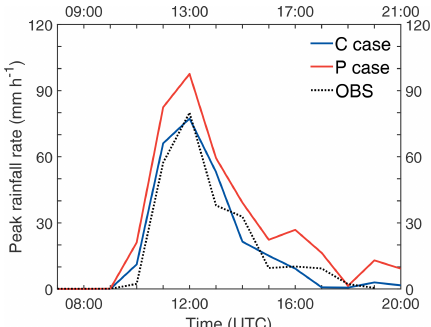
Figure 6. Temporal evolution of the peak rainfall rate for obser- vation and simulations. The dashed black line represents the ob- servation; the red line corresponds to the P case, and the blue line corresponds to the C case. The x axis above is for the observation; the x axis below is for the simulations.